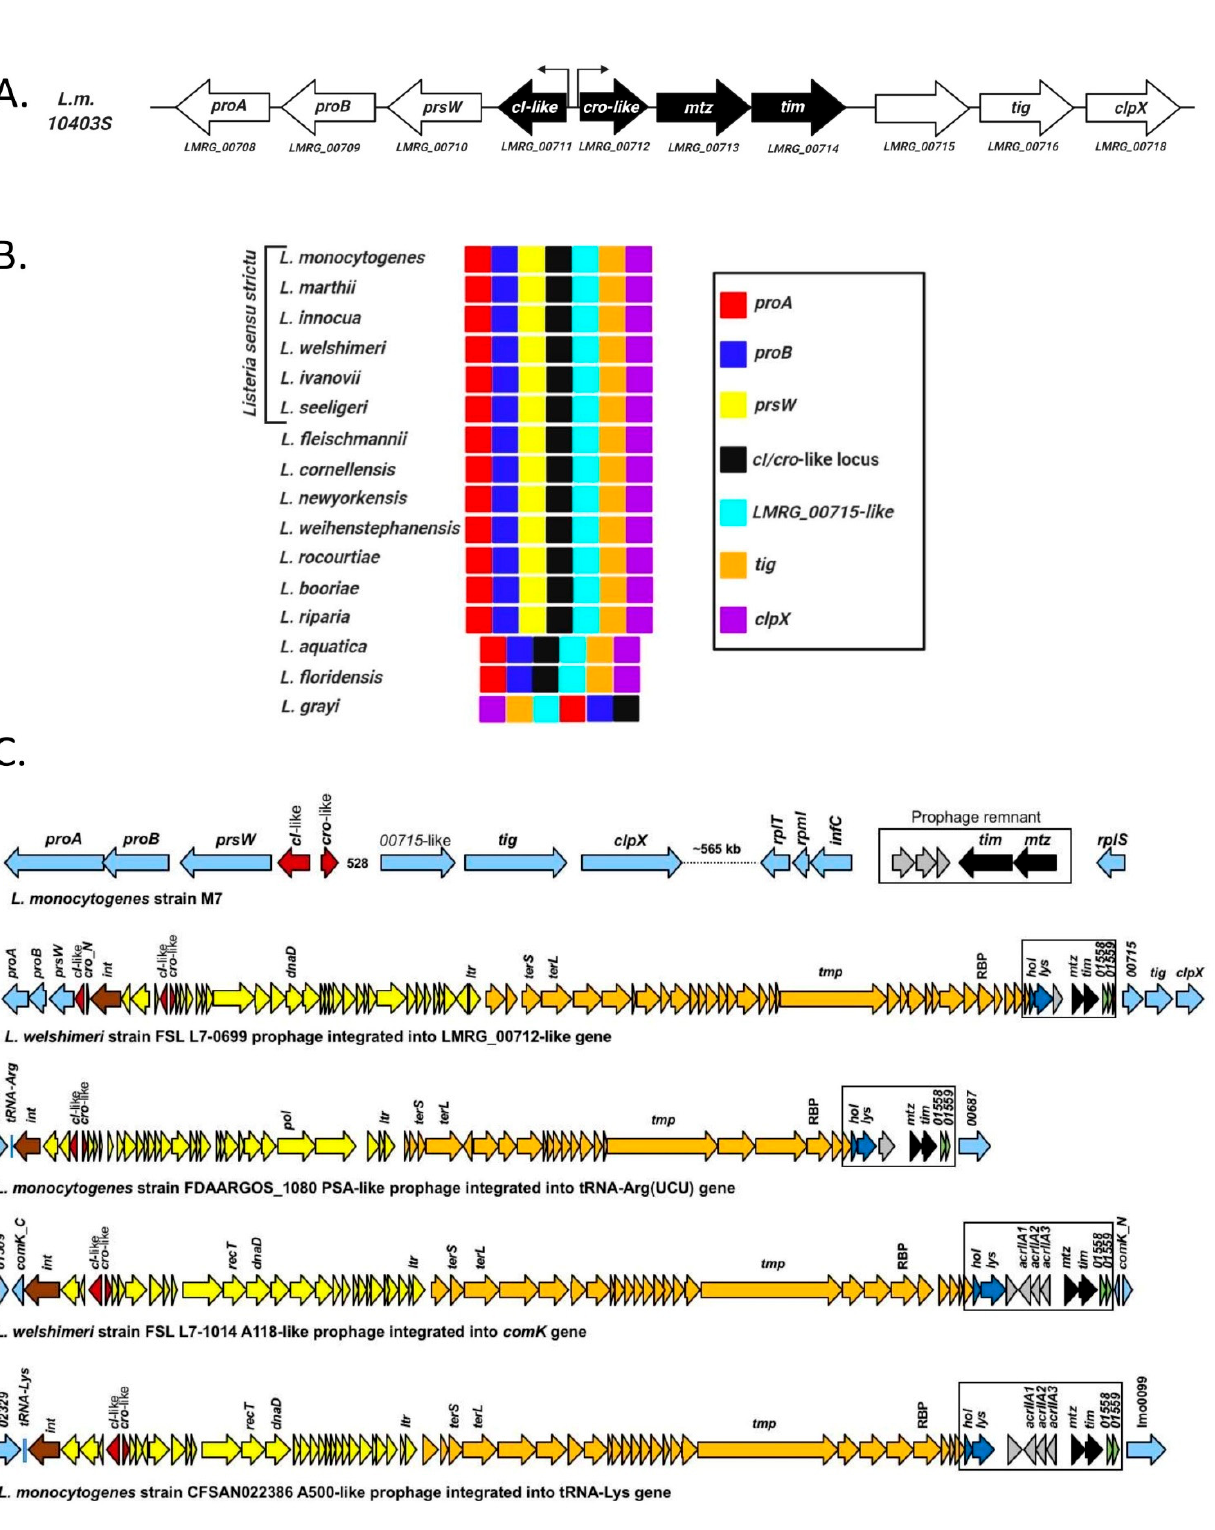
Figure 1. Bioinformatic analysis of the cI-cro- like locus. ( A ) Schematic representation of the cI-cro- like locus and proximal genes in Lm strain 10403S. ( B ) The cI-cro- like locus and its proximal genes are highly conserved in the Listeria genus, with slight variation only in L. grayi . Genes are presented in color code as indicated. ( C ) Examples of different locations of the metzincin-TIMP-like pair ( mtz-tim ) in other members of the Listeria sensu strictu clade, specifically in various prophages, e.g., PSA-like, A118-like and A500-like. The second gene, LMRG_00714 , is located immediately after LMRG_00713 with no apparent promoter. It harbors a predicted Sec/SPII signal peptide, including a lipobox